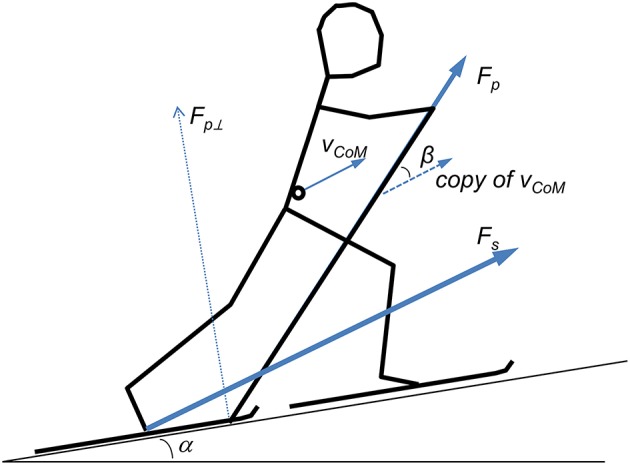
Stick diagram showing key vectors for pole force and—velocity while roller skiing. Fs, ski force; Fp, pole force; Fp⊥, pole force perpendicular on ground surface; VCoM, velocity of center of mass; α, angle of incline; β, angle between Fp and VCoM.